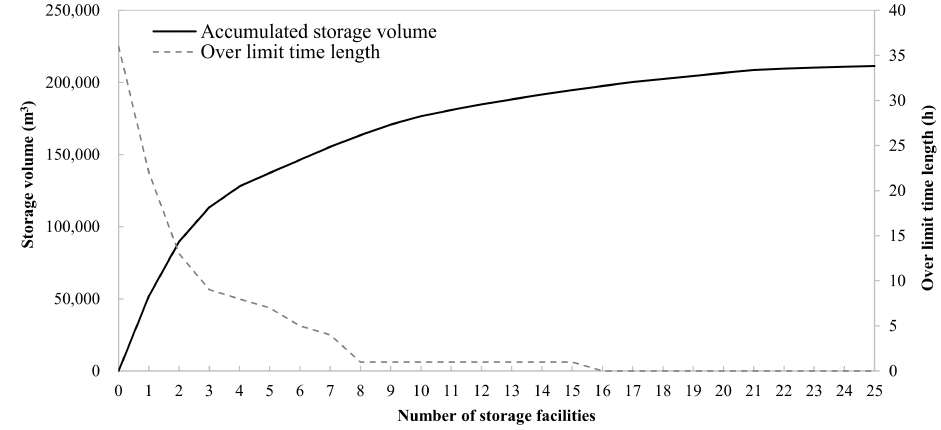
Figure 8. River quality improvement effect of different regulation